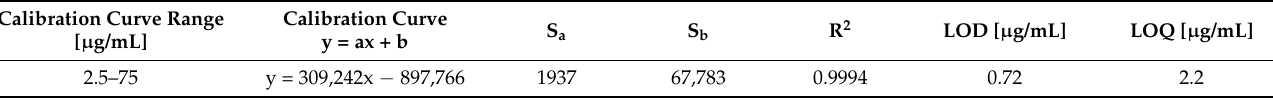
Figure 14. Calibration curve of amikacin (2.5–75 µ g/mL). Limits of detection, calculated as LOD = calibration curve intercept standard deviation multiplied by 3.3 and divided by the slope of the calibration curve and limits of quantitation LOQ = 3 × LOD were established: LOD = 0.72 µ g/mL and LOQ = 2.2 µ g/mL (Table 3). Table 3. HPLC calibration